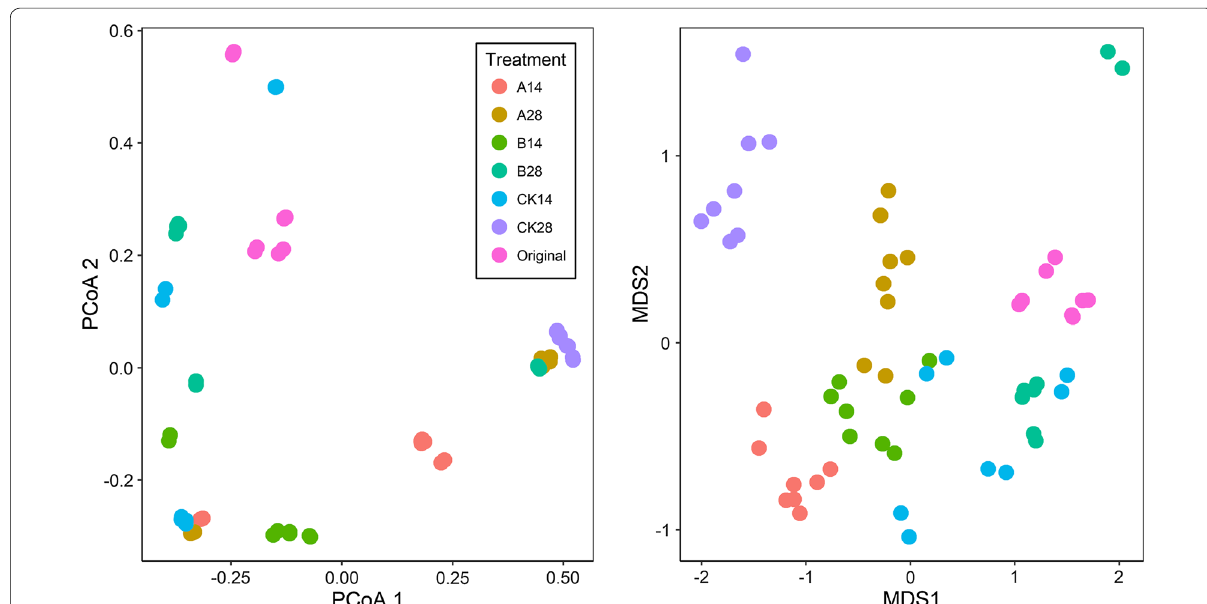
Fig. 2 Taxonomic beta-diversity of phyllosphere microbial community as indicated by principal coordinates analysis (PCoA) and non-metric multidimensional scaling (NMDS)